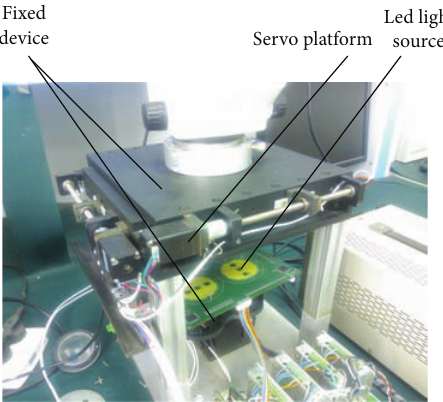
Figure 7: A photograph of cell culture cavity three-dimensional servo platform.